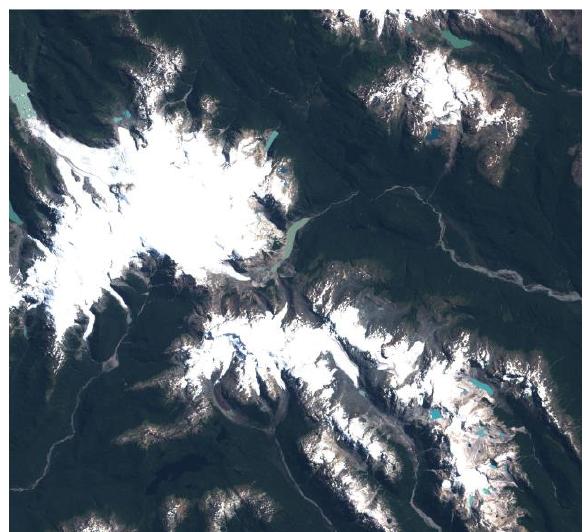
Figure 6: ESA produced 8bit True Color Image.